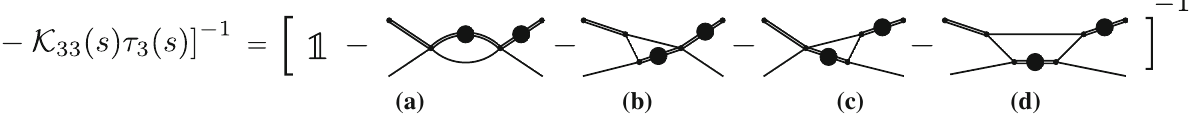
Fig. 9 The denominator of the B -matrix parameterization contains four primitive diagrams associated with the rescattering of the B -matrix: a bubble diagram, b and c triangle diagrams, and d box